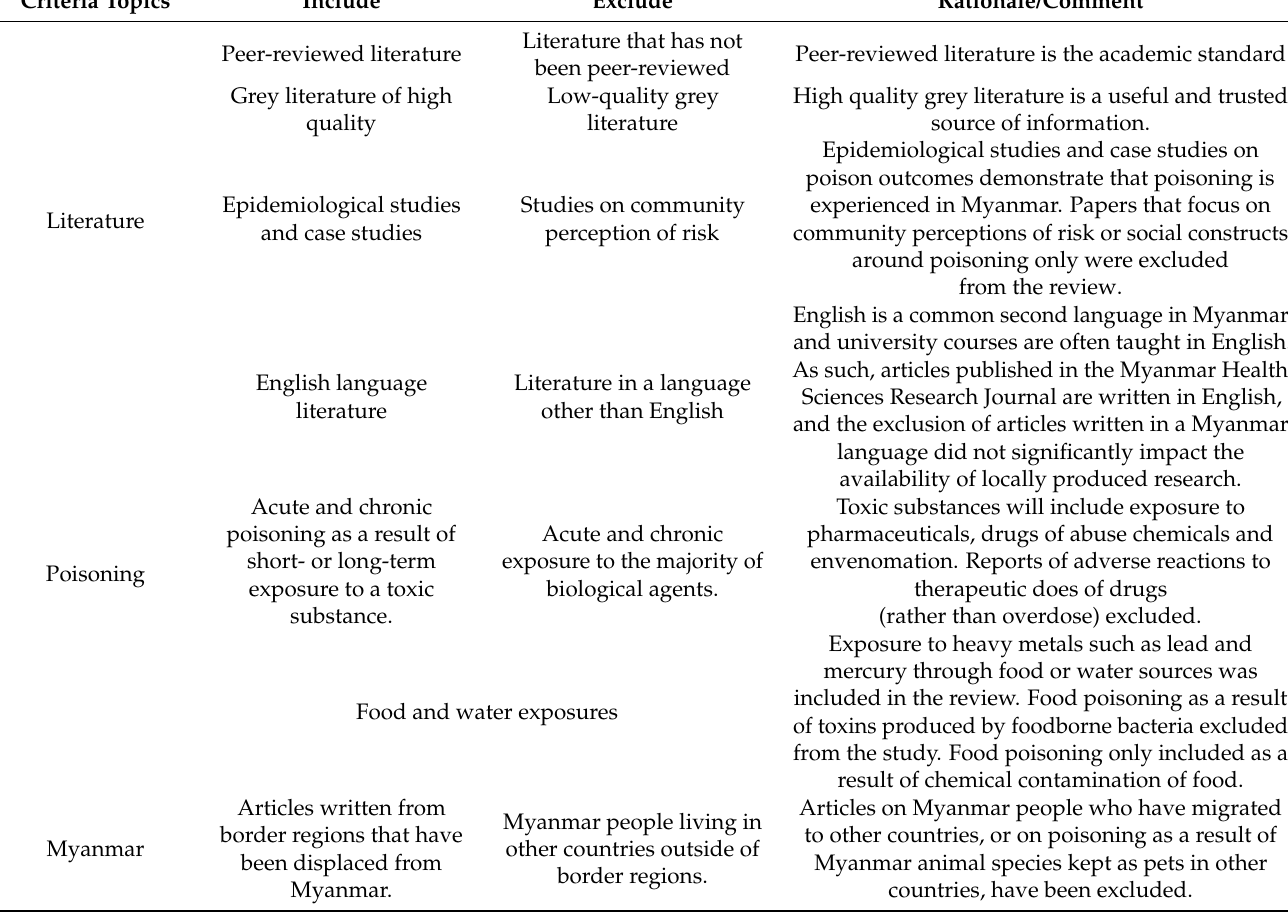
Table 1. Inclusion and exclusion